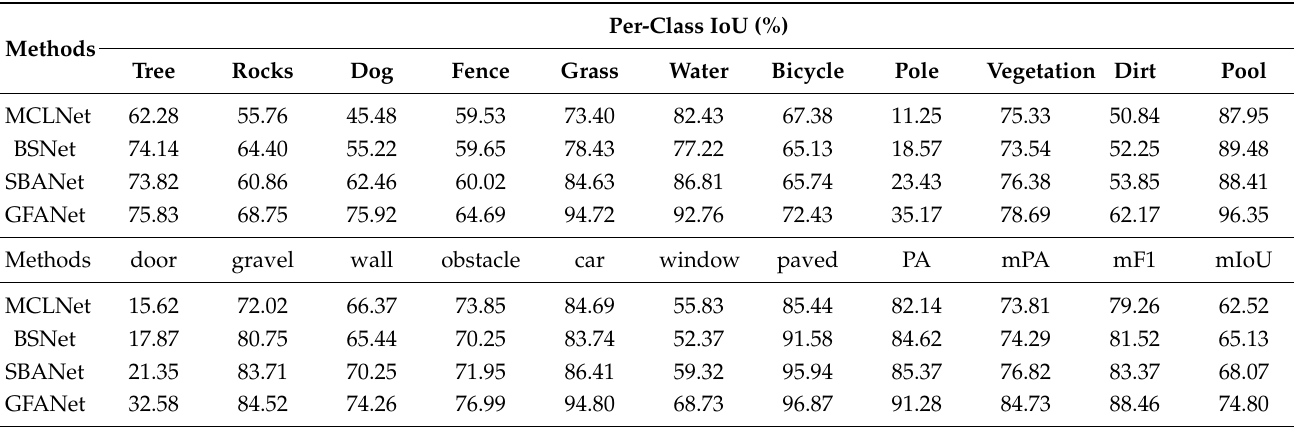
Table 3. Comparison of evaluation metrics on clean example test set in Semantic Drone dataset.